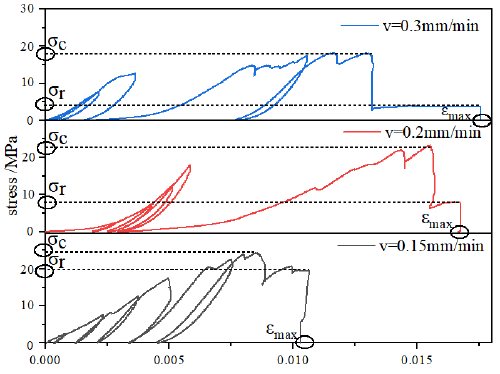
Figure 3. Stress–strain curves for different loading rates.